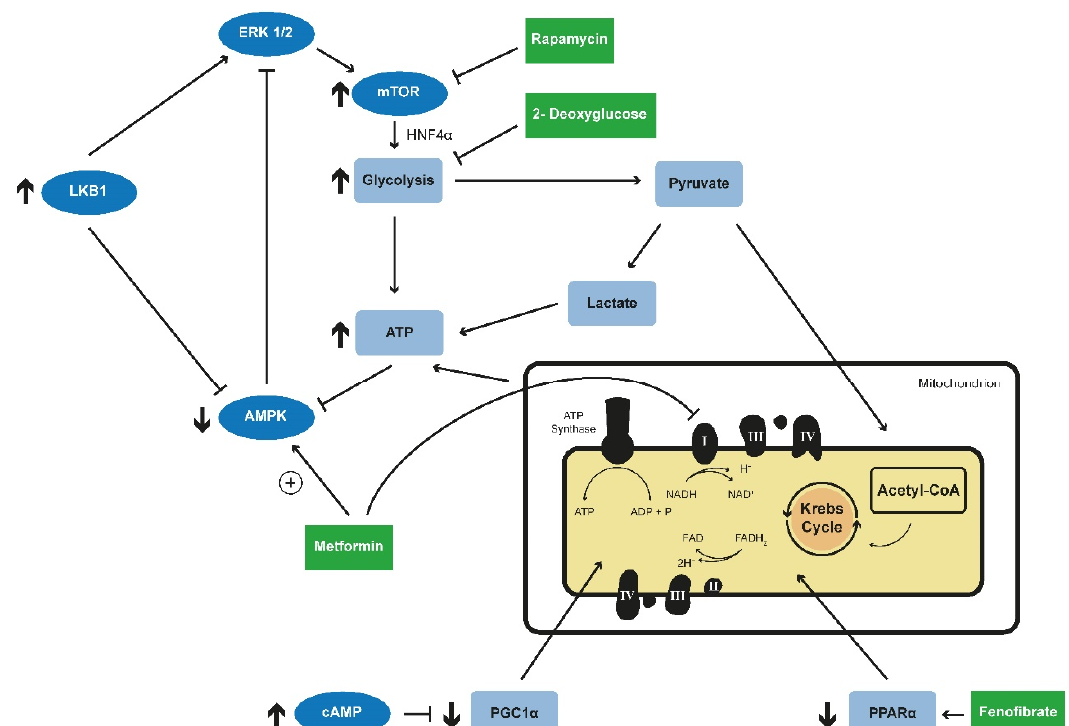
Figure 2. Targeted metabolic reprogramming in PKD. Deficiency of PC1 was shown to lead to an upregulation of ERK1 / 2, which further leads to an activation of the mTOR complex. Inhibition of mTOR by rapamycin led to promising results in animal models. Activating AMPK phosphorylation is decreased in Pkd1 -lacking cells. AMPK leads to inhibition of mTOR and is regulated itself through an ERK1 / 2-liver kinase B1 (LKB1). Metformin, a well-known drug in the treatment of diabetes type 2, was shown to activate AMPK in an ADPKD mouse model resulting in decreased cyst growth via the inhibition of mTOR. Furthermore, treatment with Metformin reduced aerobic glycolysis in animal model. Metformin is also known to inhibit complex 1 of the mitochondrial electron chain. 2-Deoxyglucose is an inhibitor of glycolysis and the treatment with 2-Deoxyglucose in different animal models